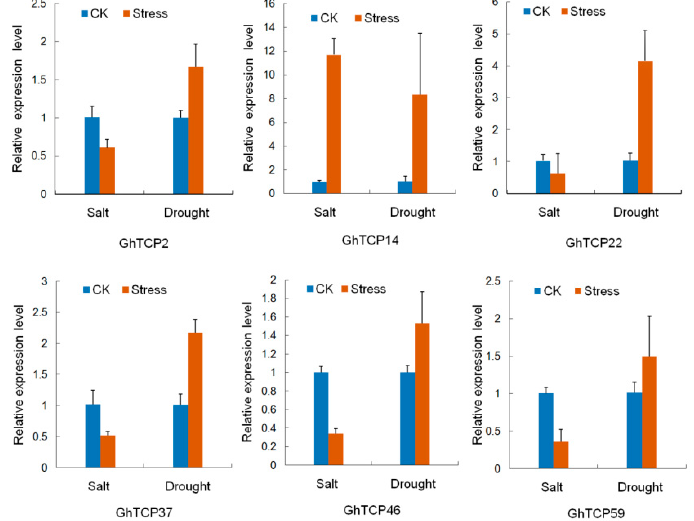
Figure 5. Relative expression levels of six GhTCP genes under salt and drought stress. QRT-PCR analyses were performed using RNA generated from cotton leaves after NaCl and Polyethylene Glycol (PEG) treatment. Error bars represent standard error of the mean.